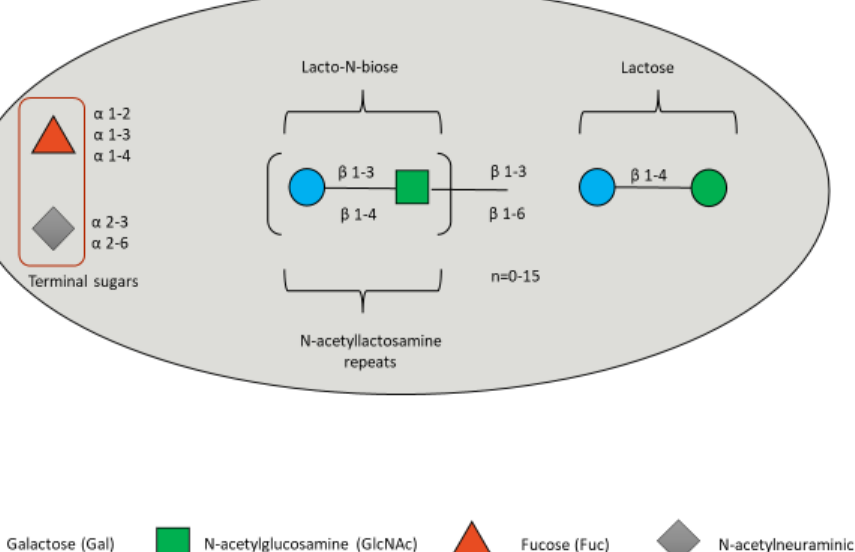
Figure 3. HMO composition blueprint. HMOs can contain 5 different monosaccharides in different number and linkages, namely glucose (green circle), galactose (blue circle), N-acetlylactosamine (green square), fucose (red triangle), and sialic acid (grey diamond).